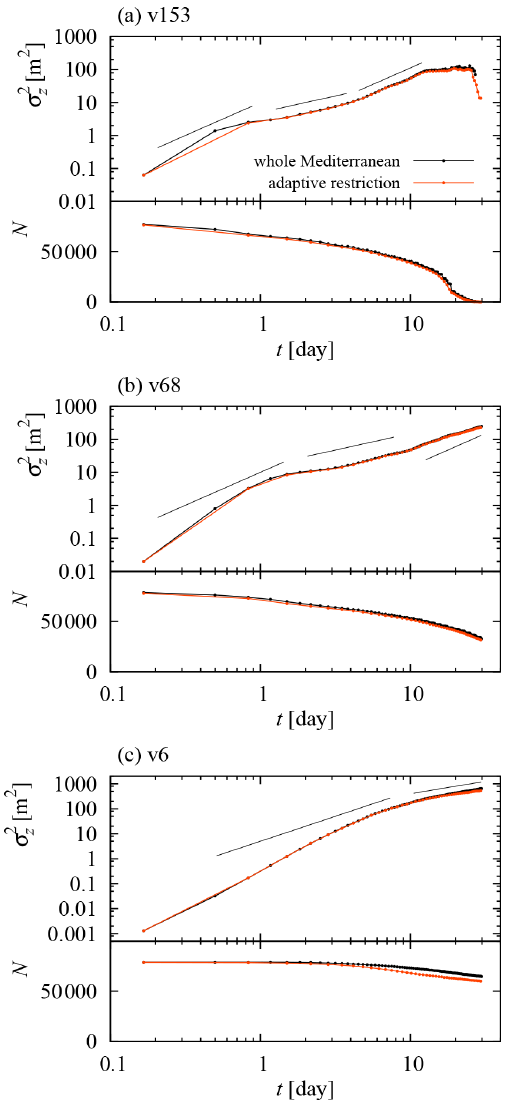
Figure C1. Variance of depth reached by all sinking particles (in black) and an adaptively restricted subset of them (in yellow) as a function of time. See text for details. Straight lines represent power laws for reference, with exponents 1 and 2. The number N of parti- cles considered for the computation of the variance is also